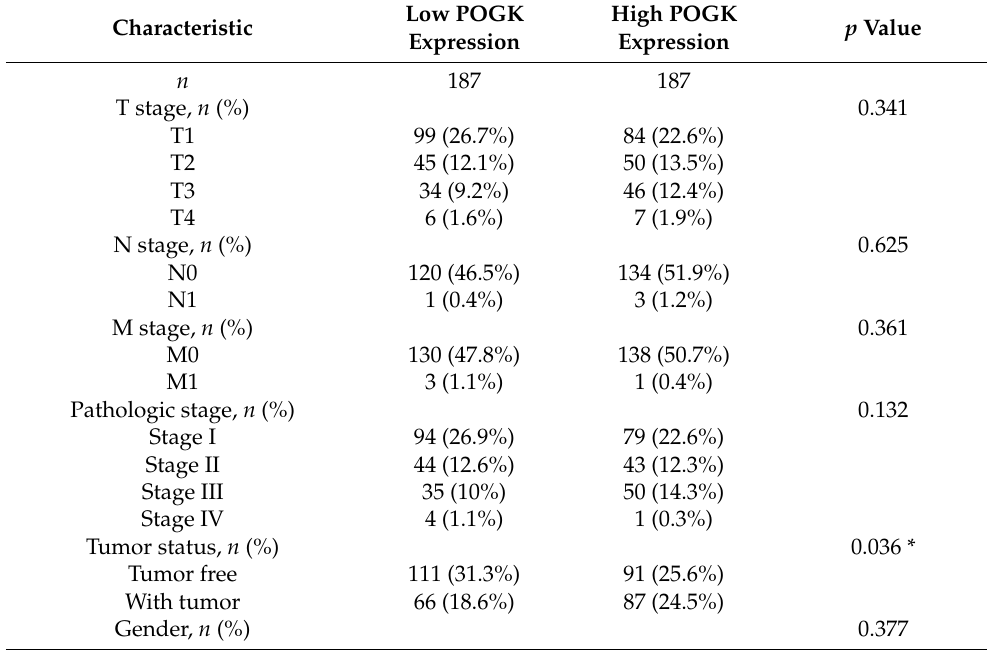
Table 1. Baseline characteristics.